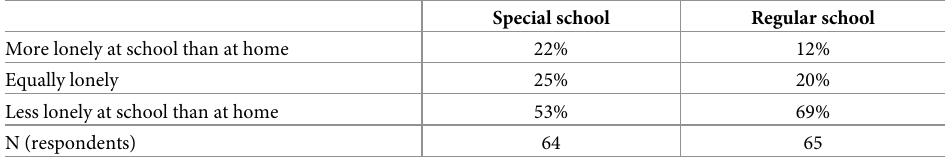
Table 2. Loneliness at school and at home.